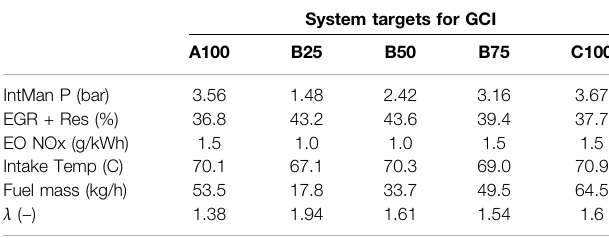
TABLE 3 | 3D CFD generated system targets for RON80 at